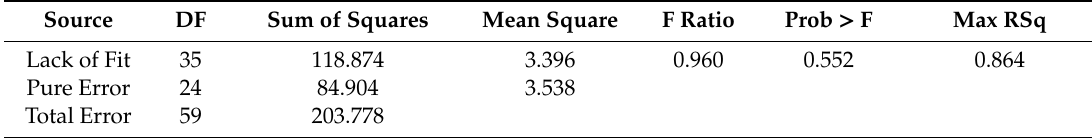
Table 9. Lack of Fit test for the model.